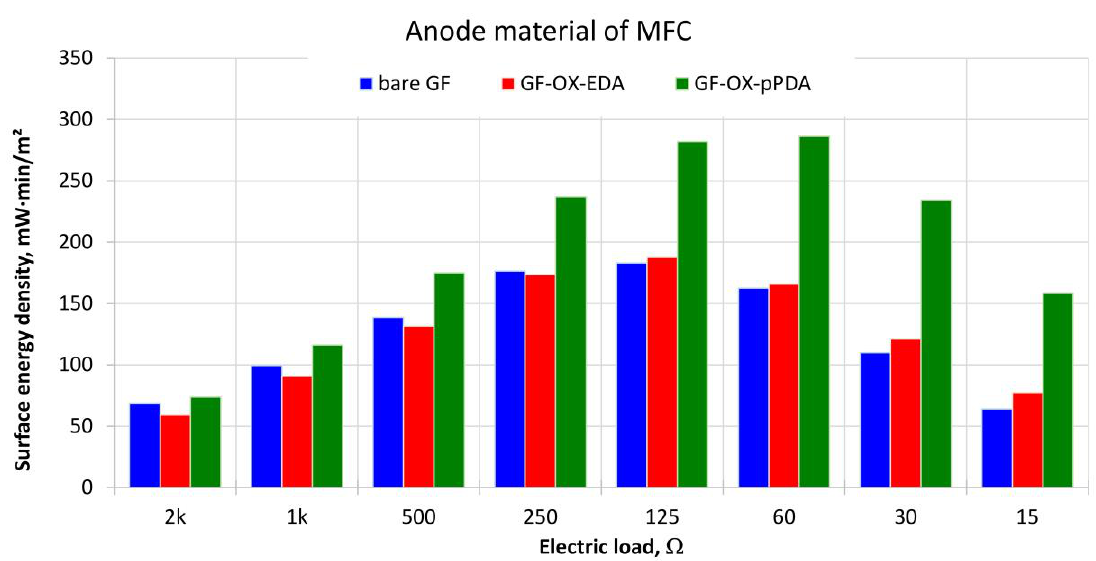
Figure 9. Dependence of MFCs’ surface energy density (over a 10 min period) on applied electrical load.